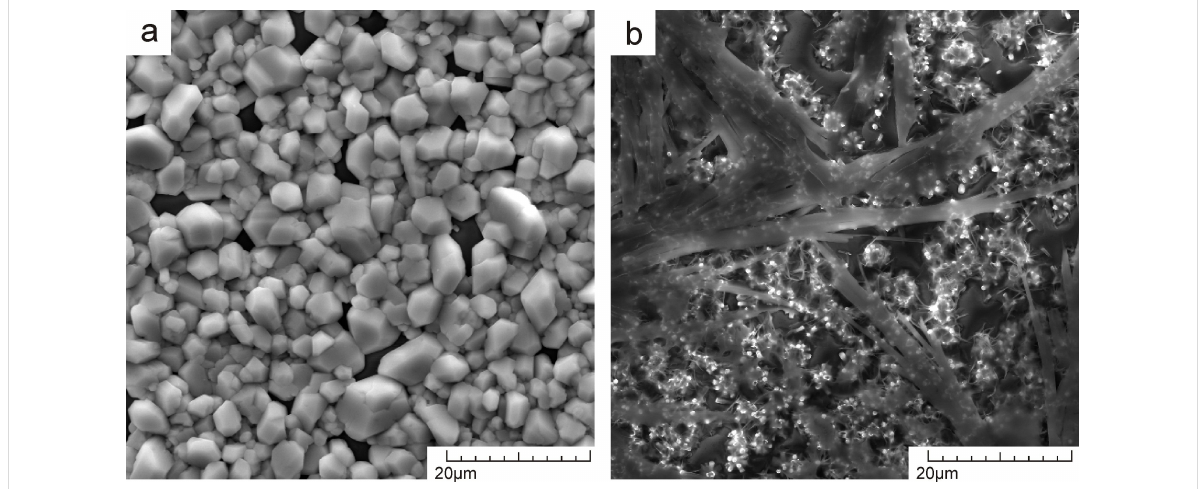
Figure 6: Sedimentation of (a) Pb(NO 3 ) 2 and (b) Cd(NO 3 ) 2 on the surface of ZnO nanotubes.